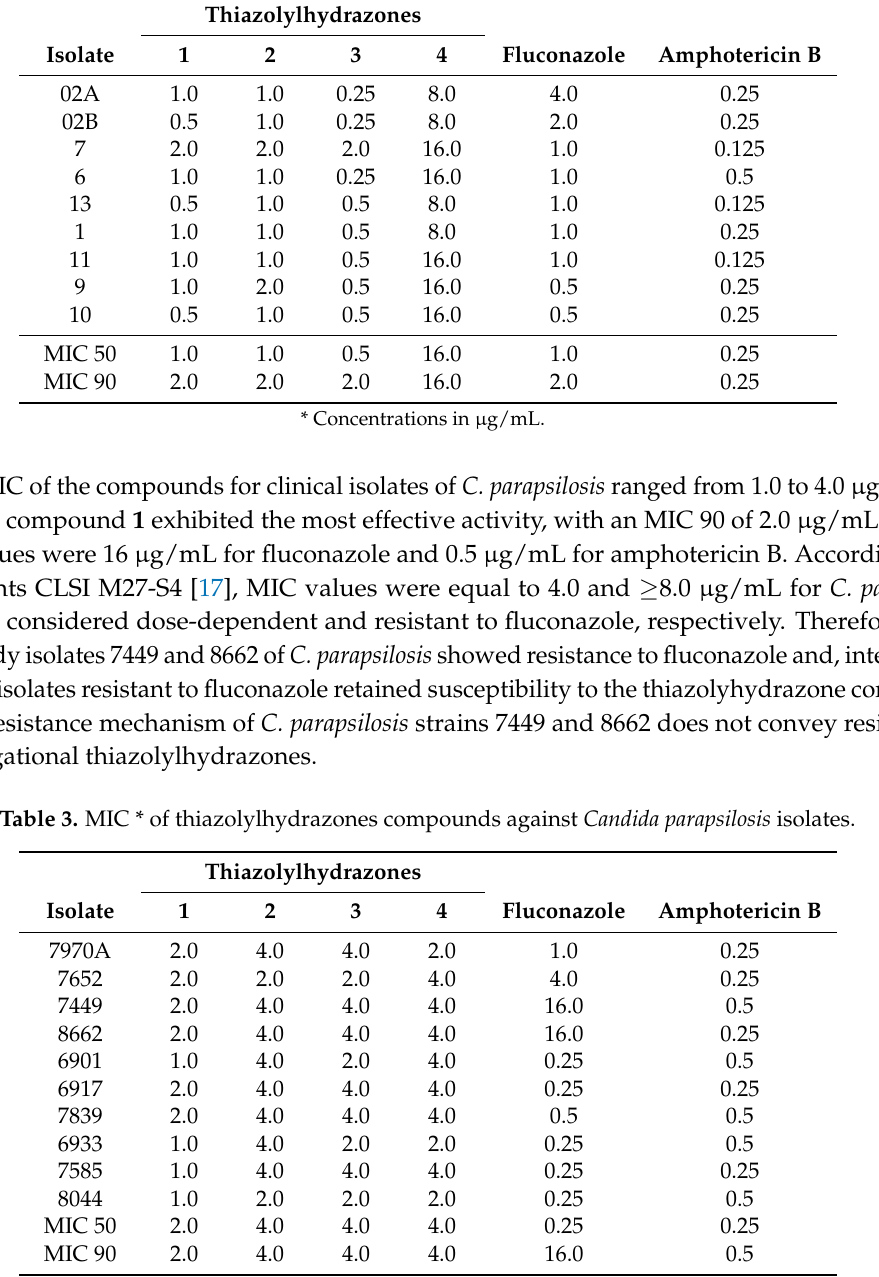
Table 2. MIC * of thiazolylhydrazones compounds against Candida albicans clinical isolates. Thiazolylhydrazones Isolate